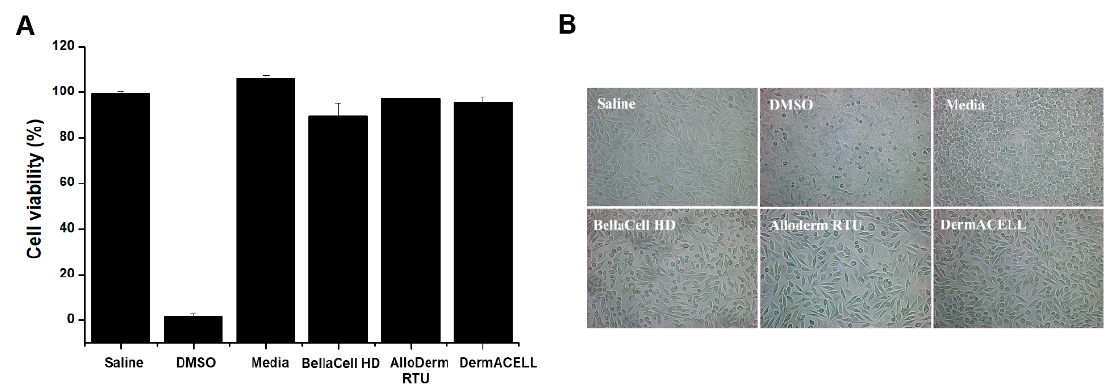
Figure 2. Biocompatibility assessment. ( A ) Cell adhesion on the surface of ADMs was observed under microscope after staining with H&E ( B ) Cell proliferation was evaluated by a 3-(4,5-dimethylthiazol-2-yl)-2,5-diphenyltetrazolium (MTT) assay. Cell adhesion and proliferation in a span of 1, 7, and 14 days. Figure 2A is a representation of cell adhesion, while Figure 2B shows the cell proliferation rate and incubation days. The cells overgrew with time in the BellaCell HD in comparison to the other two matrices, and the AlloDerm RTU cell growth was viewed at the dent. Each datum represents the ± SEM of three independent experiments.